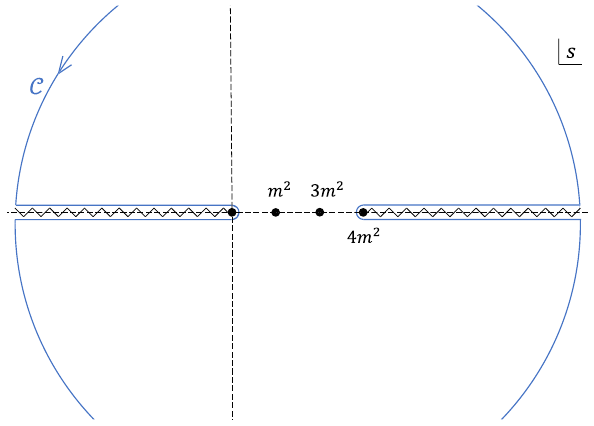
Fig. 1 The analytic structure of A ( s ) in the forward limit and the inte- gration contour C . The branch cut starts from the biparticle production threshold and extends all the way to infinity